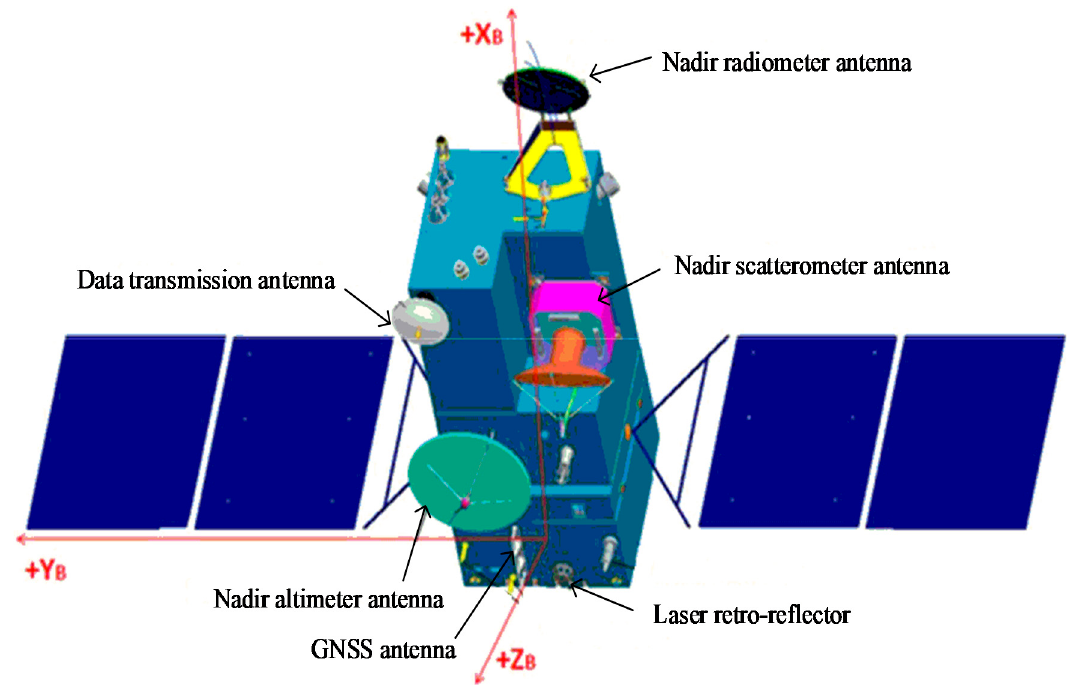
Figure 1. HY2D satellite and its payloads.